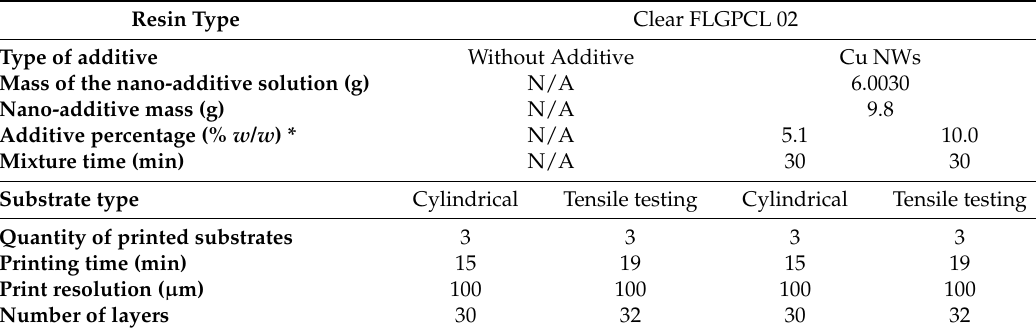
Table 1. Mass measurements of the Cu NWs and mixture and manufacturing